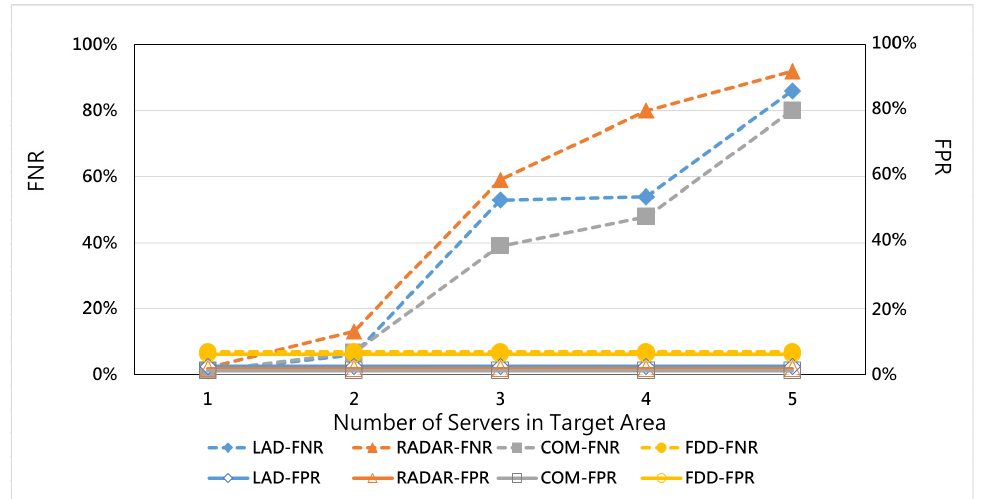
Figure 8. FNR and FPR vs. number of servers in the target area.